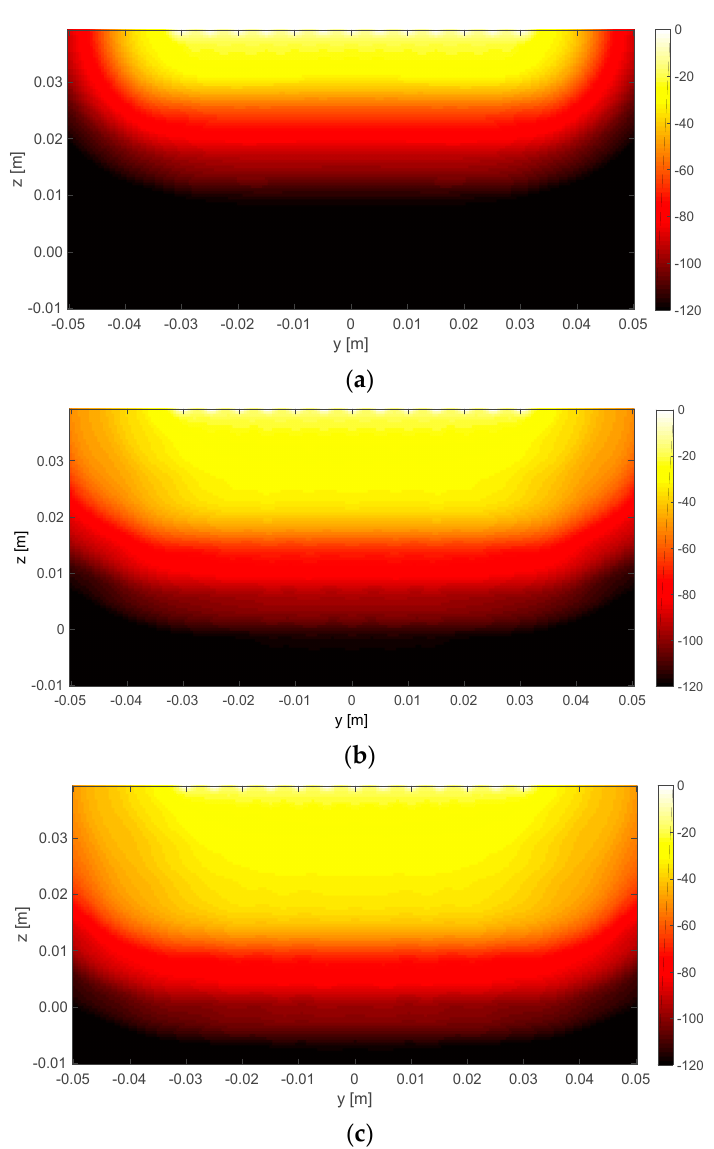
Figure 5. Spatial coverage of the operator K + for R equal to ( a ) 20; ( b ) 48; and ( c ) 60. In the study, R = 48 was set. Refer to Figure 2 for the reference system.